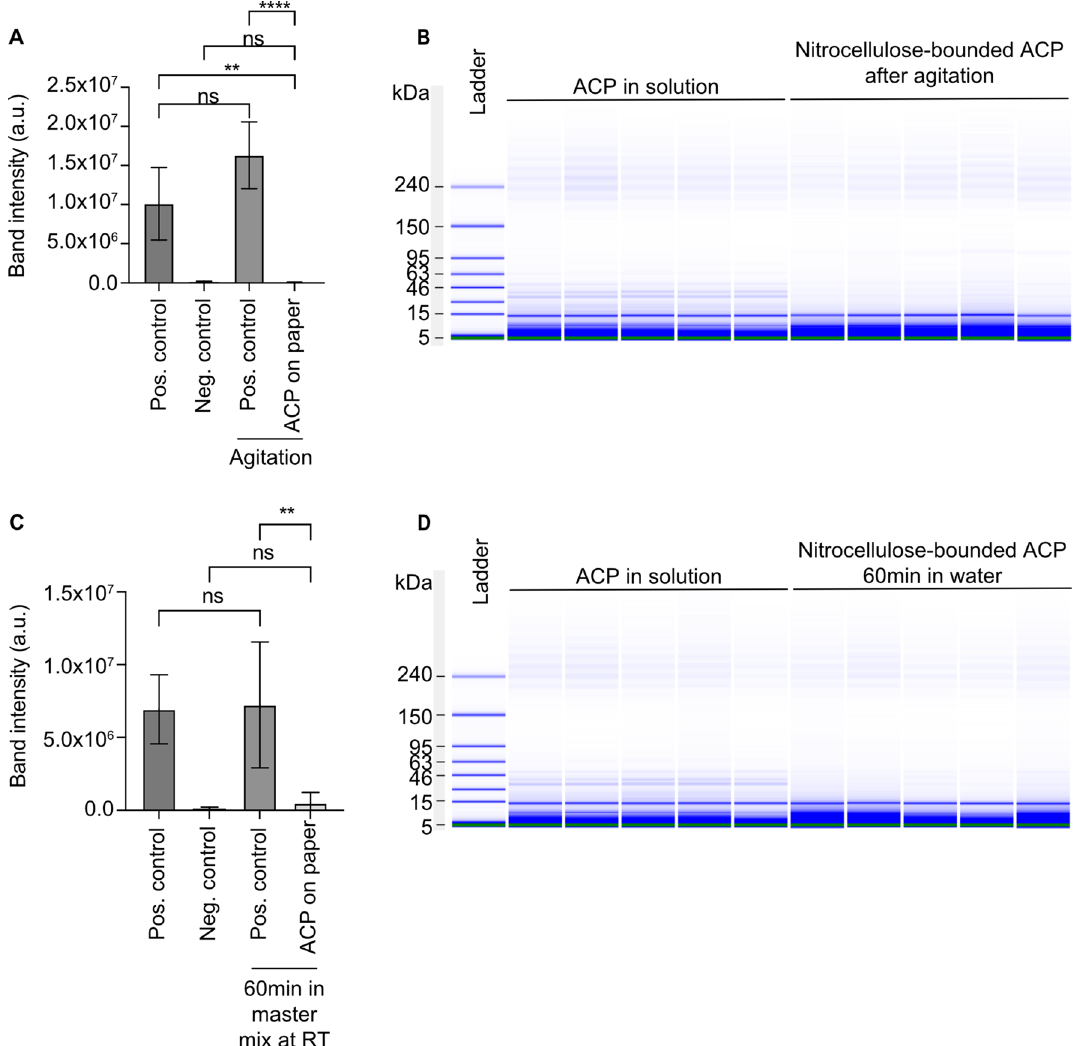
Figure 3. Effect of diffusion and agitation on the activity of nitrocellulose-bound ACP. ( A ) Densitometric analysis of agarose gel electrophoresis results in Fig. S3 showing that nitrocellulose-bound ACP is capable of RPA inhibition when mixed (n = 5 for all conditions, unpaired t-test, mean with SD). ( B ) No ACP (30 to 50 kDa) was detected by chip-based electrophoresis in water where nitrocellulouse-bound ACP was submitted to agitation. Full-length gel image is presented in Fig. S5. ( C ) Densitometric analysis of agarose gel electrophoresis results in Fig. S6 showing that nitrocellulose-bound ACP is capable of high to complete RPA inhibition within 60 min, possibly by diffusion of amplification enzymes to the ACP on the paper surface (n = 5 for all conditions, unpaired t-test, mean with SD). ( D ) No ACP (30 to 50 kDa) was detected by chip-based electrophoresis in water where nitrocellulose-bound ACP was left for 60 min. Full-length gel image is shown in Fig.